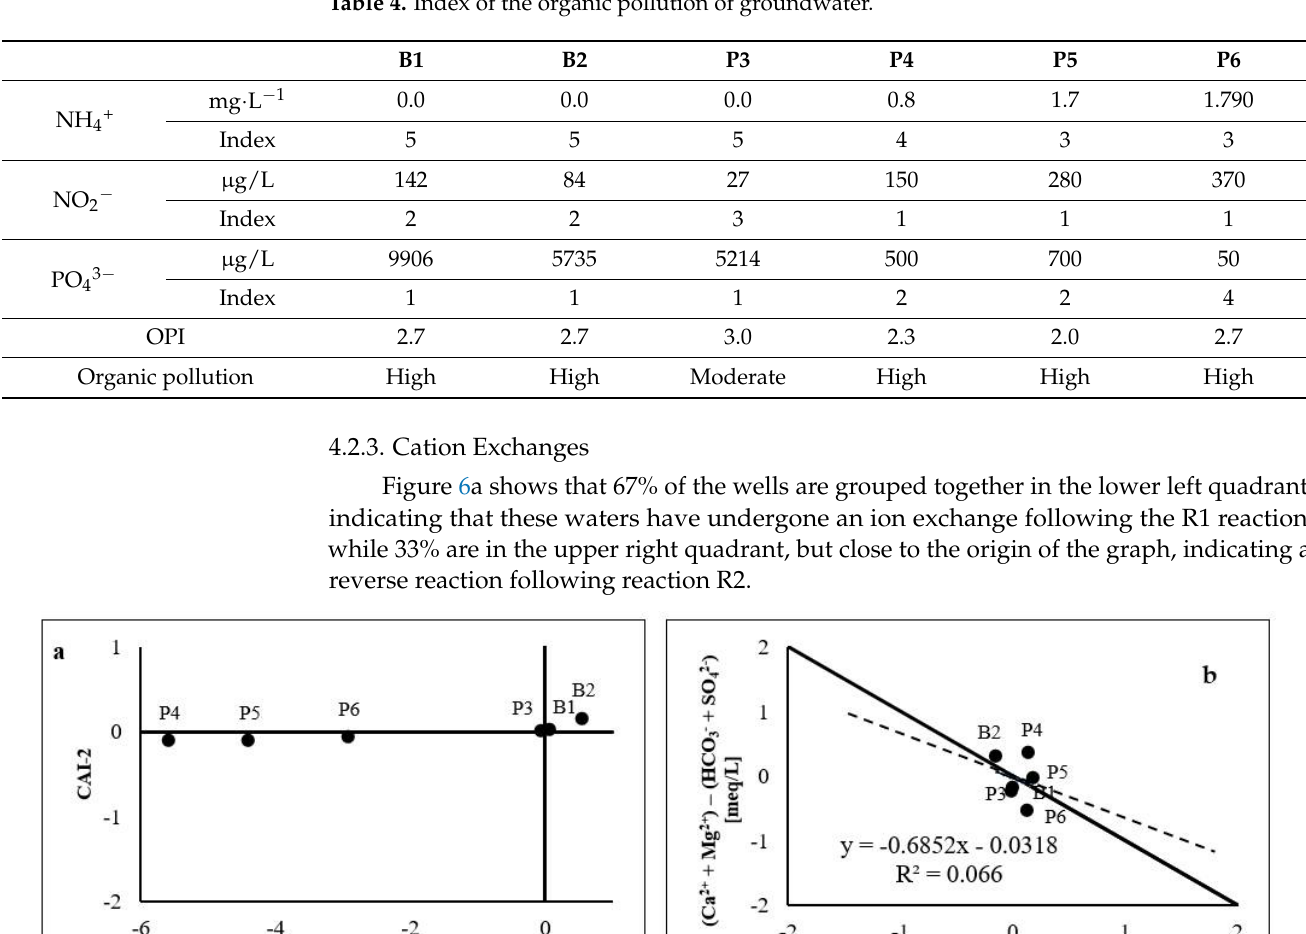
Table 4. Index of the organic pollution of groundwater.